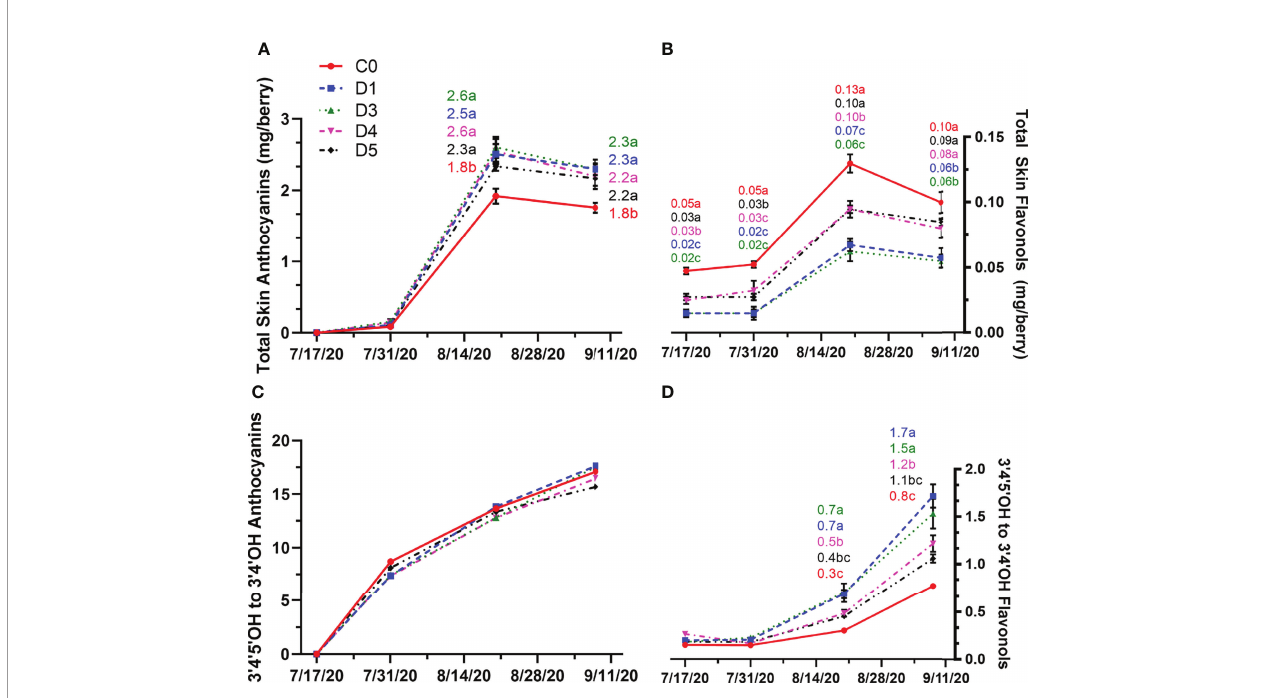
FIGURE 6 | Total skin anthocyanin (A) and fl avonol (B) content and anthocyanin (C) and fl avonol (D) hydroxylation pro fi le (ratio of 3 ’ 4 ’ -OH and 3 ’ 4 ’ 5 ’ -OH) throughout berry development in untreated (C0) and shade fi lm treatments (D1, D3, D4, D5) in 2020. Points are means ± standard error ( n = 4). Means with no letters in common are signi fi cantly different (p ≤